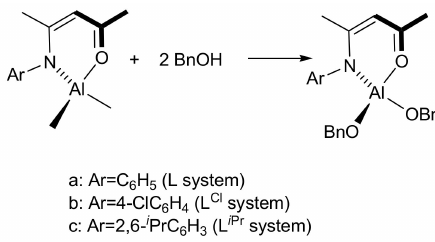
Figure 1. A series of aluminum ketiminate complexes bearing di ff erent substituents for the ring-opening polymerization of ε -caprolactone and L -lactide.